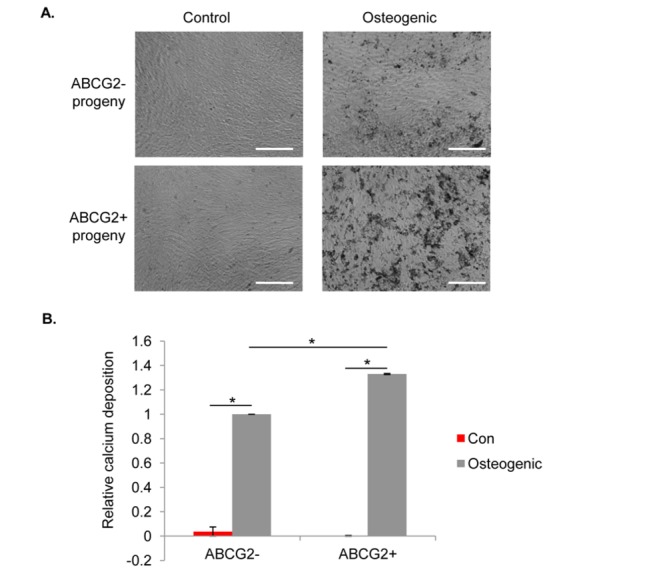
ABCG2+ valvular cells deposit more calcified matrix than ABCG2- cells in osteogenic conditions.Sorted ABCG2+ and ABCG2- valvular cells were grown to confluence and re-plated in osteogenic media for 8 days. (A) Brightfield images of cells cultured in control conditions or osteogenic conditions were taken at day 8. ABCG2+ progeny secreted more dark mineralization spots than ABCG2- progeny on plastic plates. Scale bar: 100 µm. (B) Calcium deposition by the cells was quantified as described in the Materials and Methods. Data was represented as mean + standard error. Compared with ABCG2- progeny, ABCG2+ progeny produced higher amounts of calcium composites at day 8 (* indicates p<0.05 in between the groups).